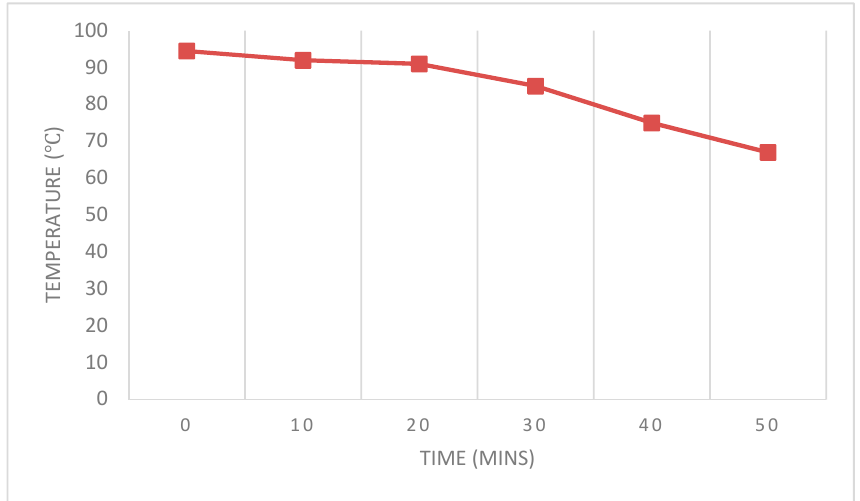
Figure 14. Plot of temperature vs. discharge time after 1 h.